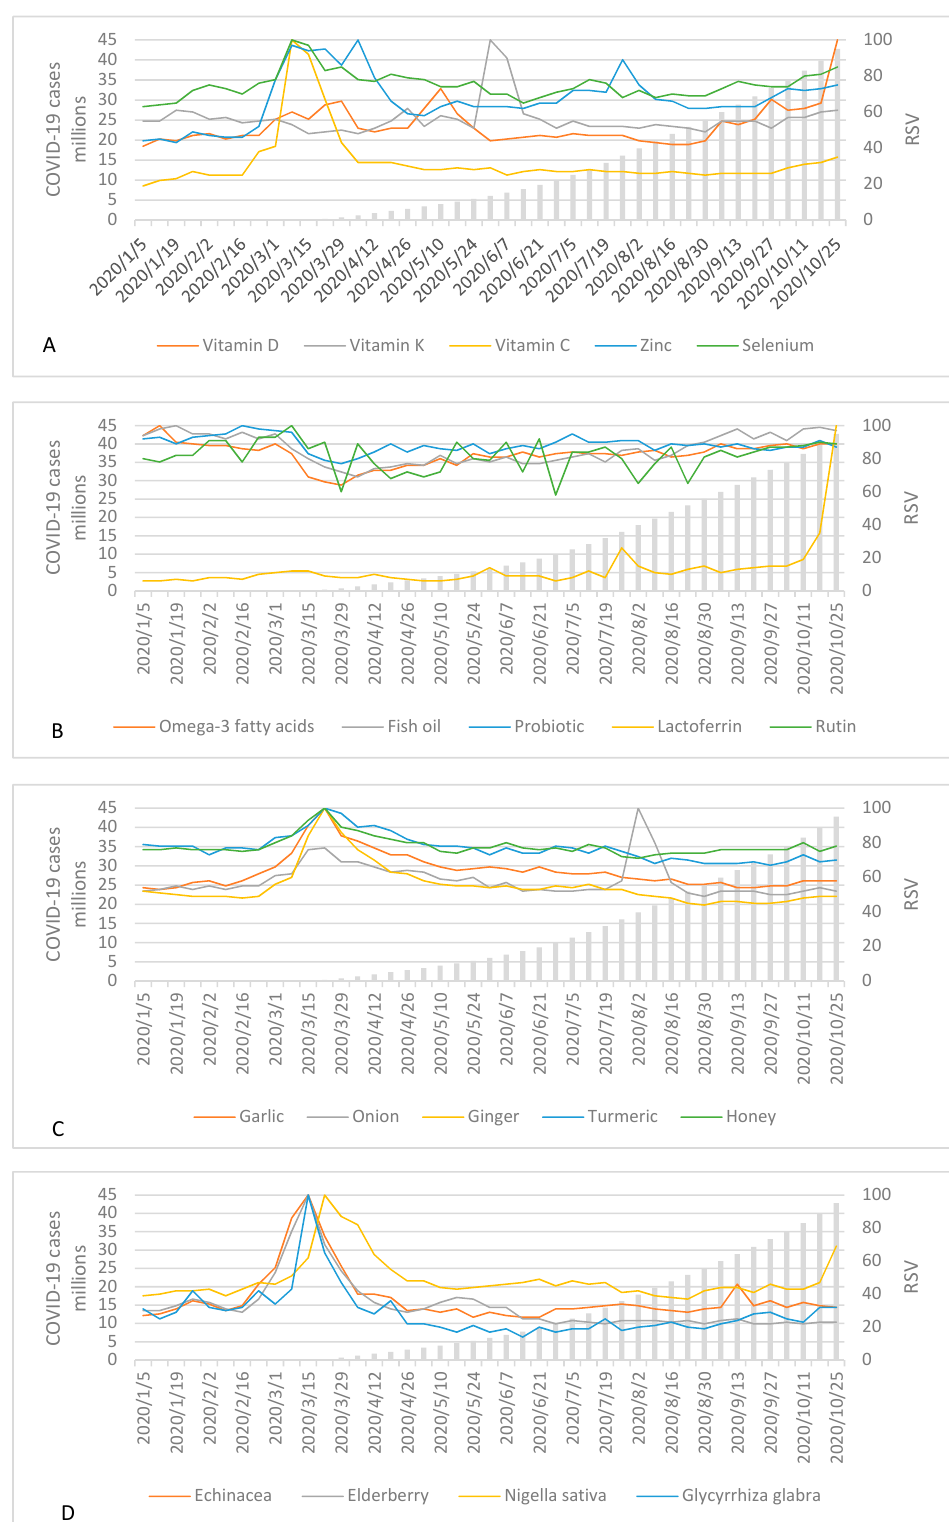
Figure 2. Trend curves of RSVs (relative search values) for nutrients, bioactive compounds, and herbs search queries and cumulative confirmed COVID-19 cases in the world between 1 January and 31 October2020. ( A ) vitamins D, K, C, zinc, selenium; ( B ) omega-3 fatty acids, fish oil, probiotics, lactoferrin, rutin; ( C ) garlic, onion, ginger, turmeric, honey; ( D ) echinacea, elderberry, Nigella sativa , Glycyrrhiza glabra .